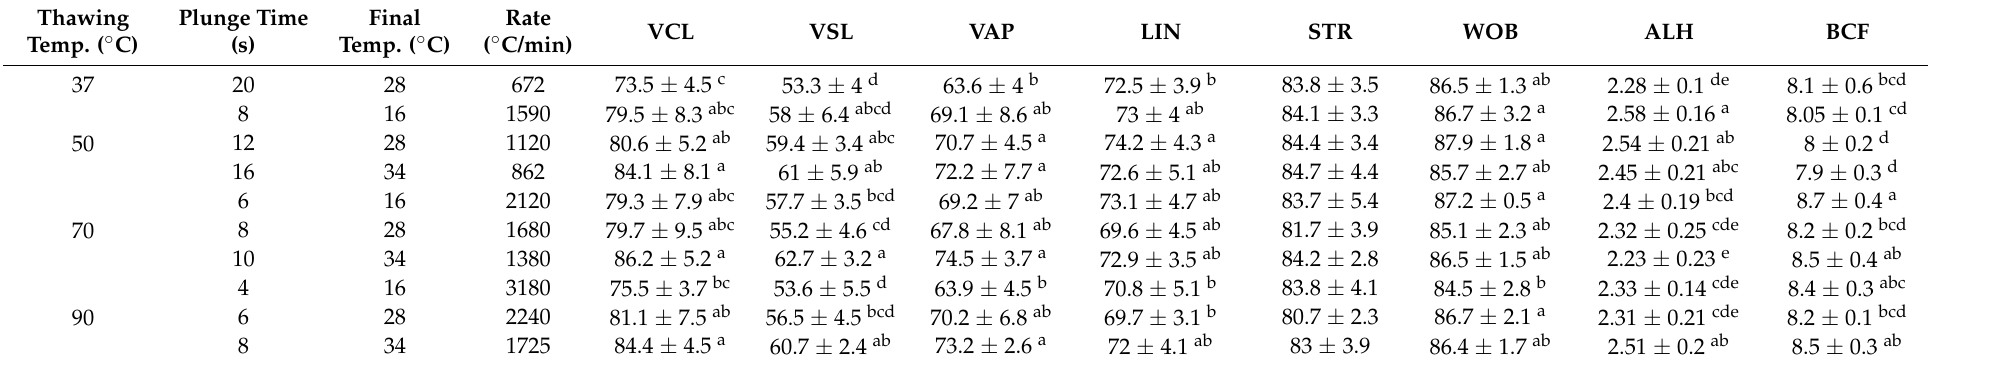
Table 2. Evaluation of different thawing conditions: Effect on kinematic parameters.